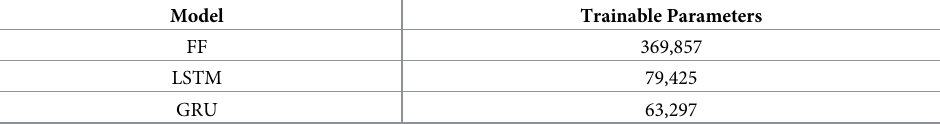
Table 1. Number of trainable parameters for each of the neural network